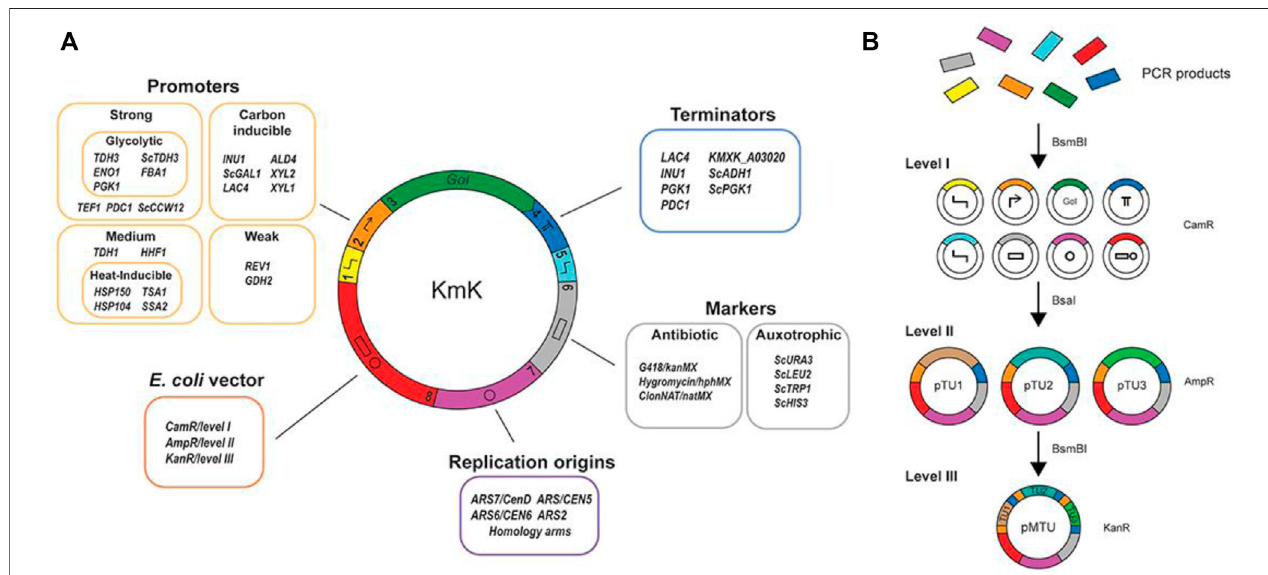
FIGURE 3 | Collection of biological parts and synthetic biology tools for Kluyveromyces marxianus . Reproduced with permission from Rajkumar et al. (2019); an open-access article distributed under the terms of the Creative Commons Attribution License (CC